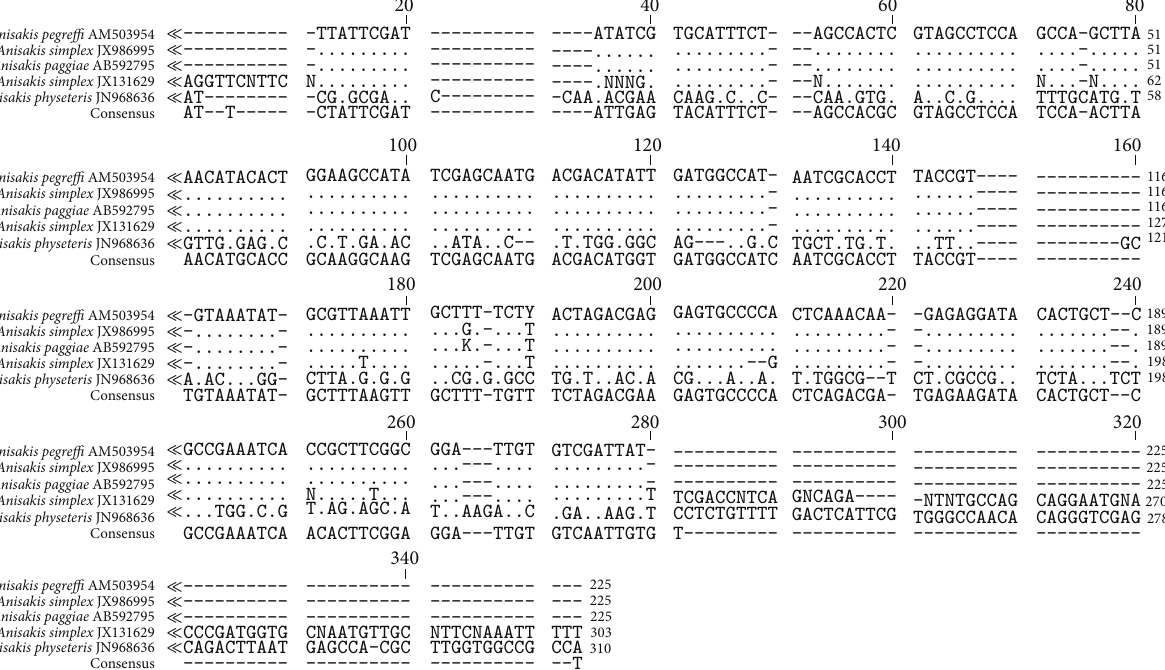
Figure 3: Sequence alignment of A. simplex (L3) with most related species. Note: only variable sites are shown. Dots represented bases identical to those of the first sequences and dashes indicate